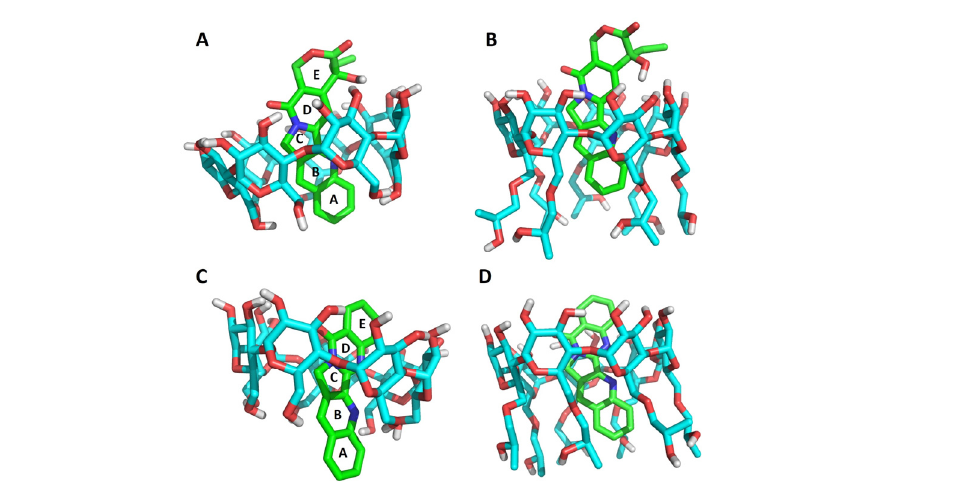
Figure 4. Docking of camptothecin and luotonin A inside the cyclodextrin cavities: ( A ) camptothecin– β -CD complex; ( B ) camptothecin-HP- β -CD complex; ( C ) luotonin A– β -CD complex; ( D ) luotonin A-HP- β -CD complex.